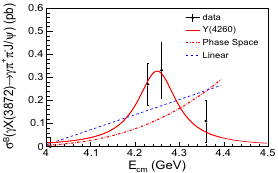
Figure 1. Fit to the summed π + π − J /ψ invariant mass spectrum. Dots with error bars are data, and the curves are the best fit.